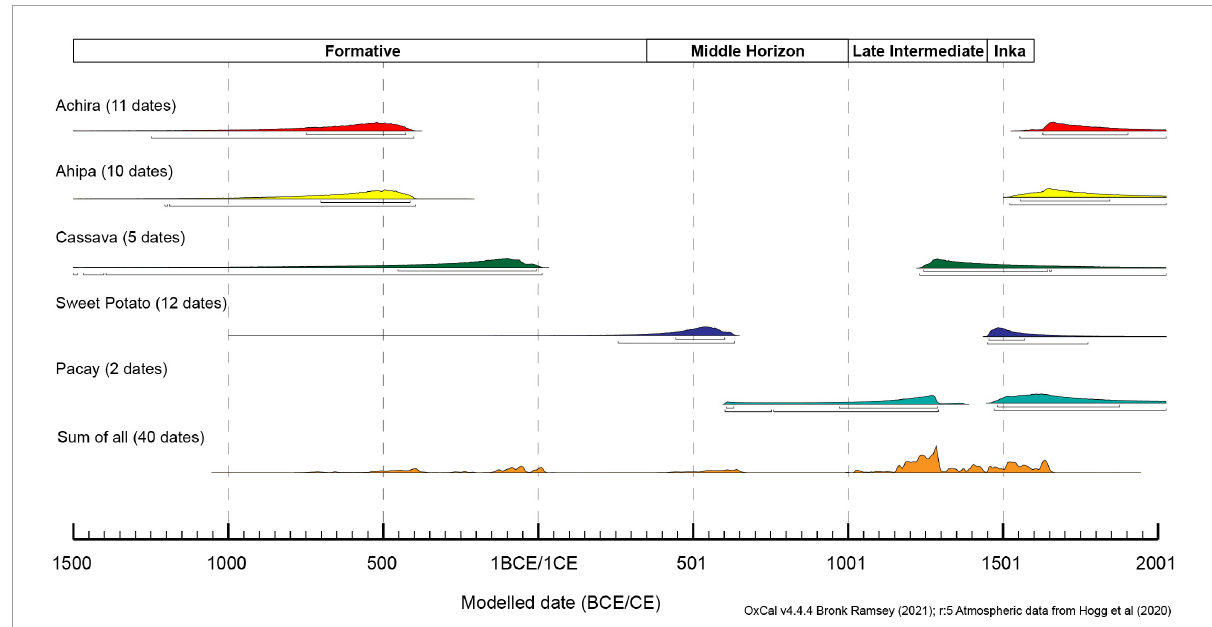
FIGURE4 Modeled phases for calibrated radiocarbon dating of archeological plant